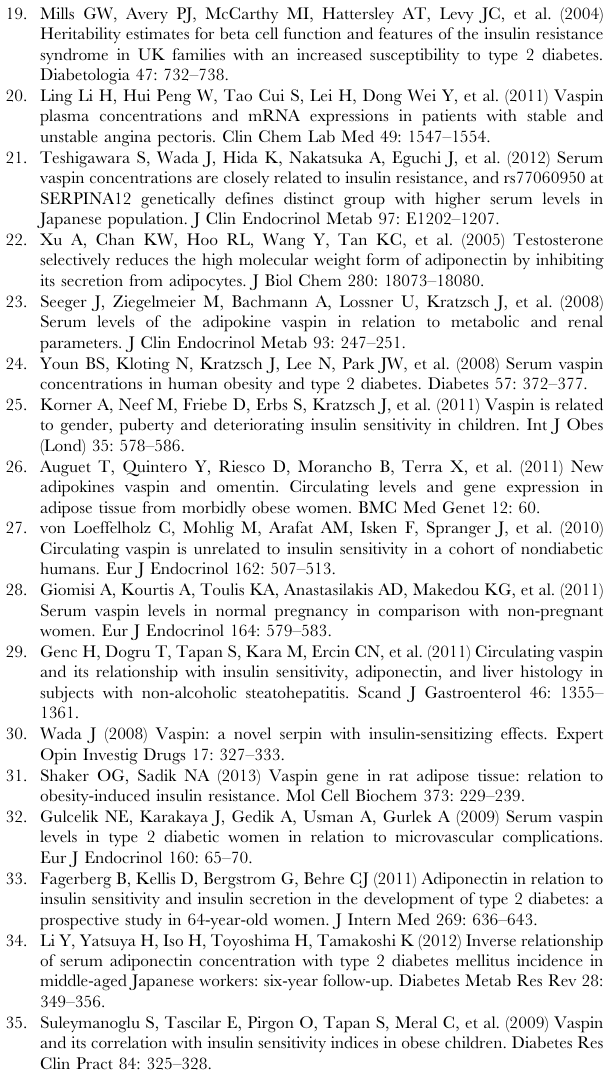
Table S1 Basic clinical characteristics of all subjects